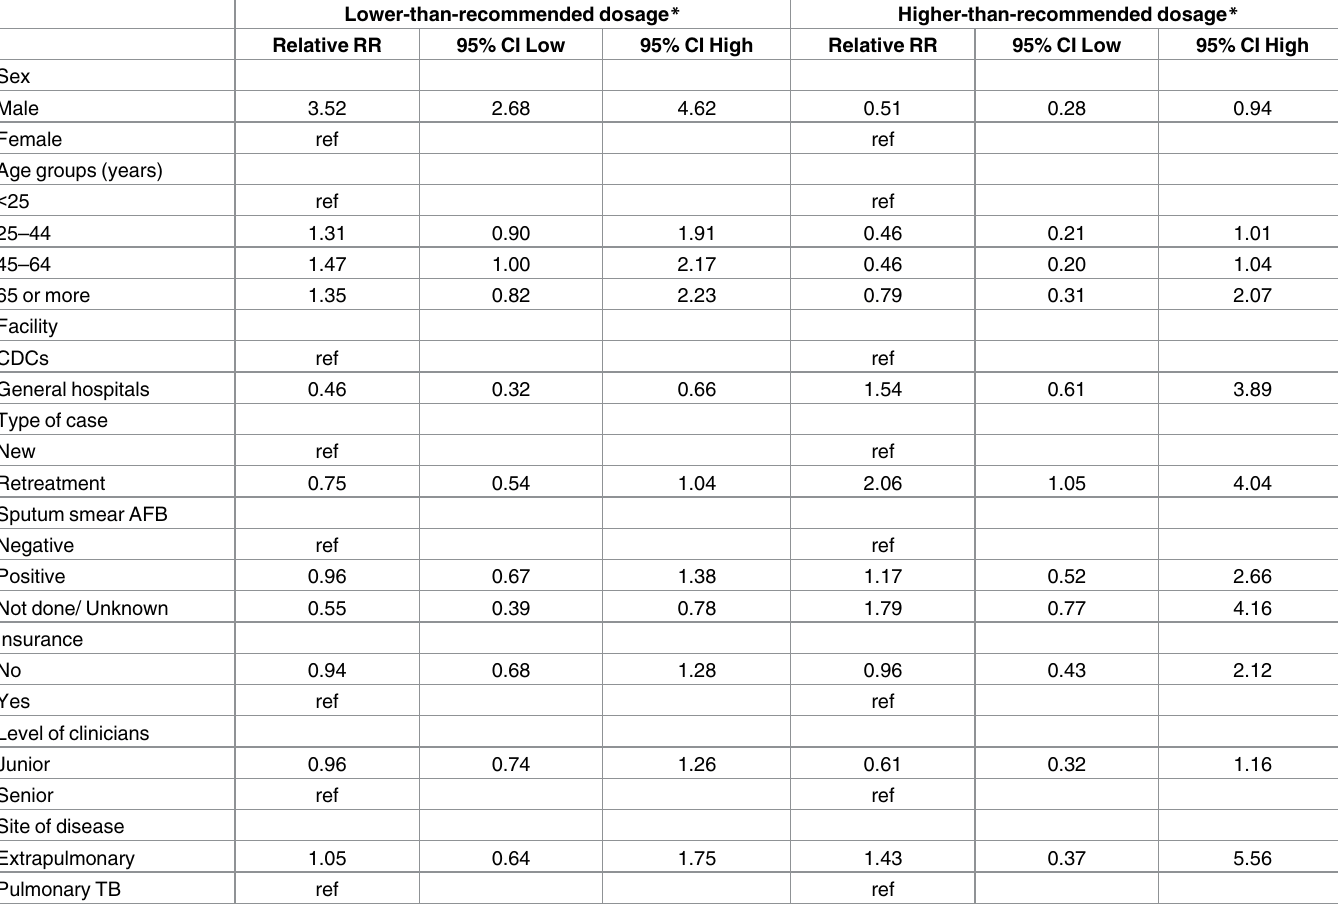
Table 10. Factors associated with inadequate dosing of ethambutol,